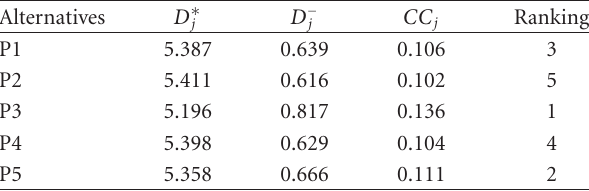
Table 6: Fuzzy TOPSIS